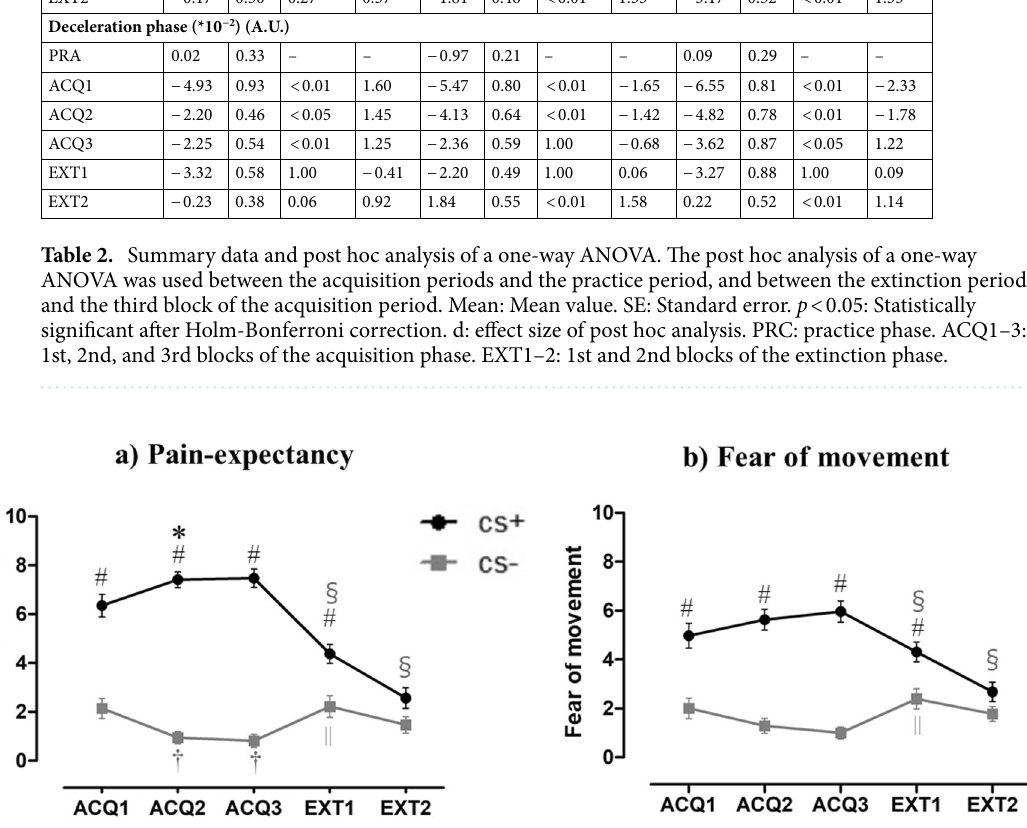
Figure 3. ( a ) The mean pain expectancy rating (+ SEs) for the CS movements. ( b ) The mean fear of movement rating (+ SEs) for the CS movements. ACQ1–3: 1st, 2nd, and 3rd blocks of the acquisition phase. EXT1–2: 1st and 2nd blocks of the extinction phase. #Significant difference between CS+ movement and CS− movement ( p < 0.05). *Significant difference in CS+ movement between the practice and other phases ( p < 0.05). †Significant difference in CS− movement between the practice and other phases ( p < 0.05). §Significant difference in CS+ movement between the 3rd block of the acquisition phase and the other phases ( p < 0.05). ||Significant difference in CS− movement between the 3rd block of the acquisition phase and other phases ( p <